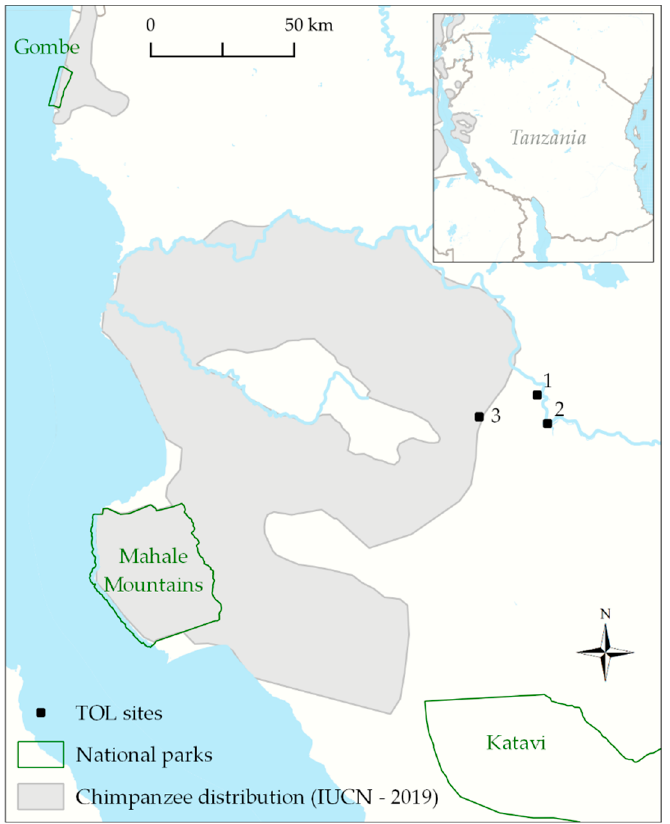
Figure 1. Map of the western Tanzania region in which the flights were conducted. TOL = take-off and landing. Table 1. Results from N-mixture models using data from Bonnin et al.